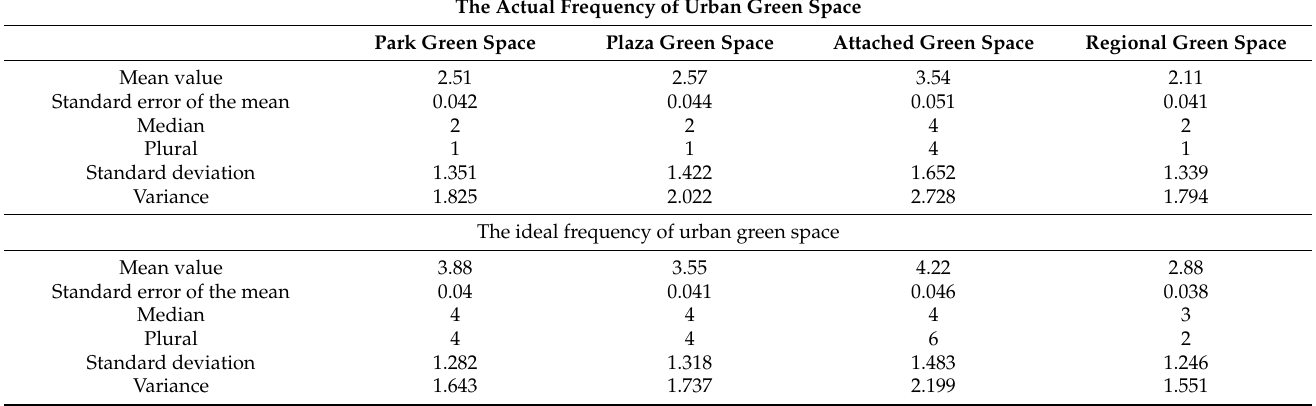
Table 2. The actual frequency and ideal frequency that respondents go to the four types of urban green spaces. Ratings are as the illustration shows.